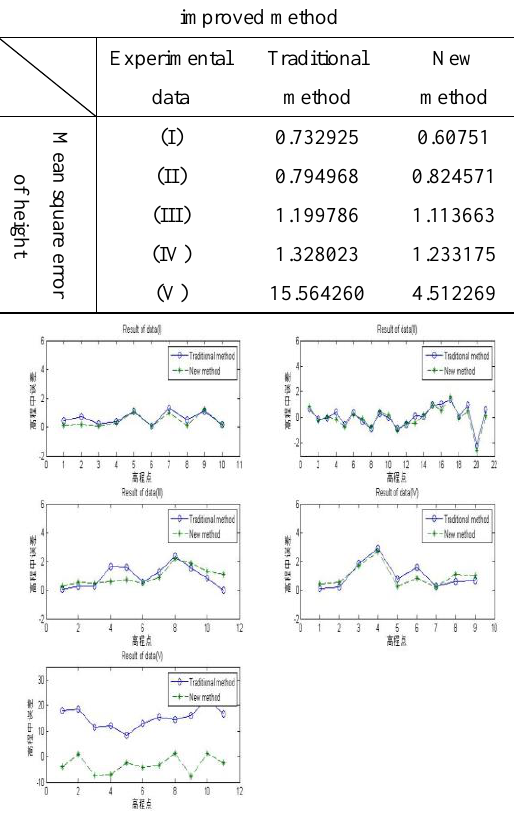
Table 2. Comparison between traditional method and